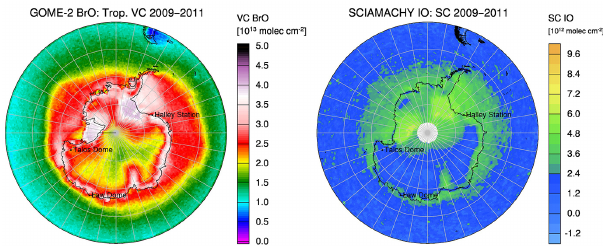
Figure 8. Average atmospheric column concentrations of BrO and IO in Antarctica between 2009 and 2011 from Spolaor et al.